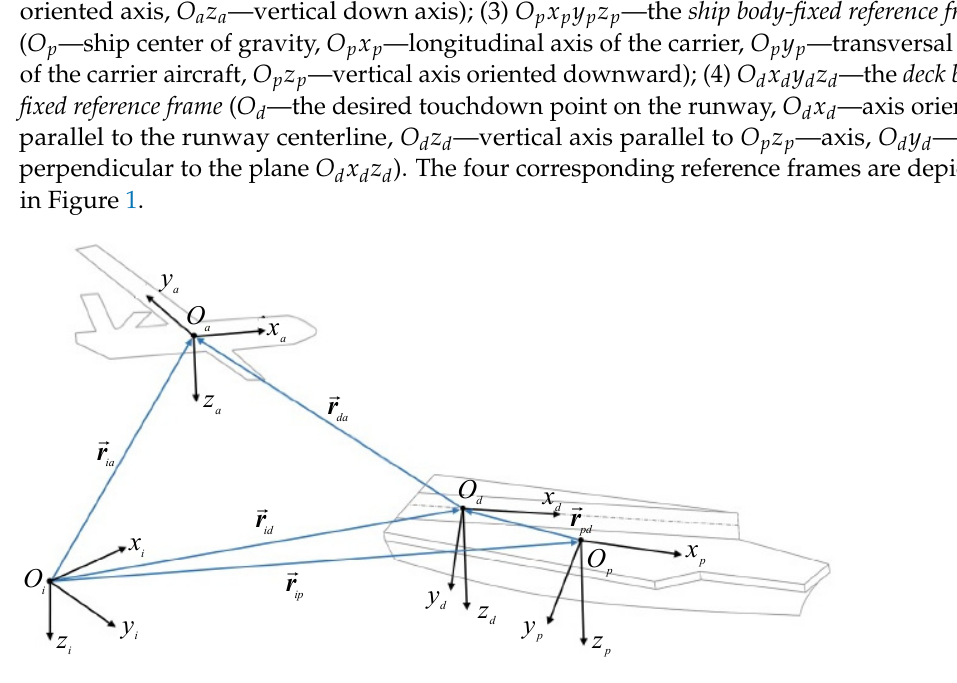
Figure 1. Landing geometry and reference frames.